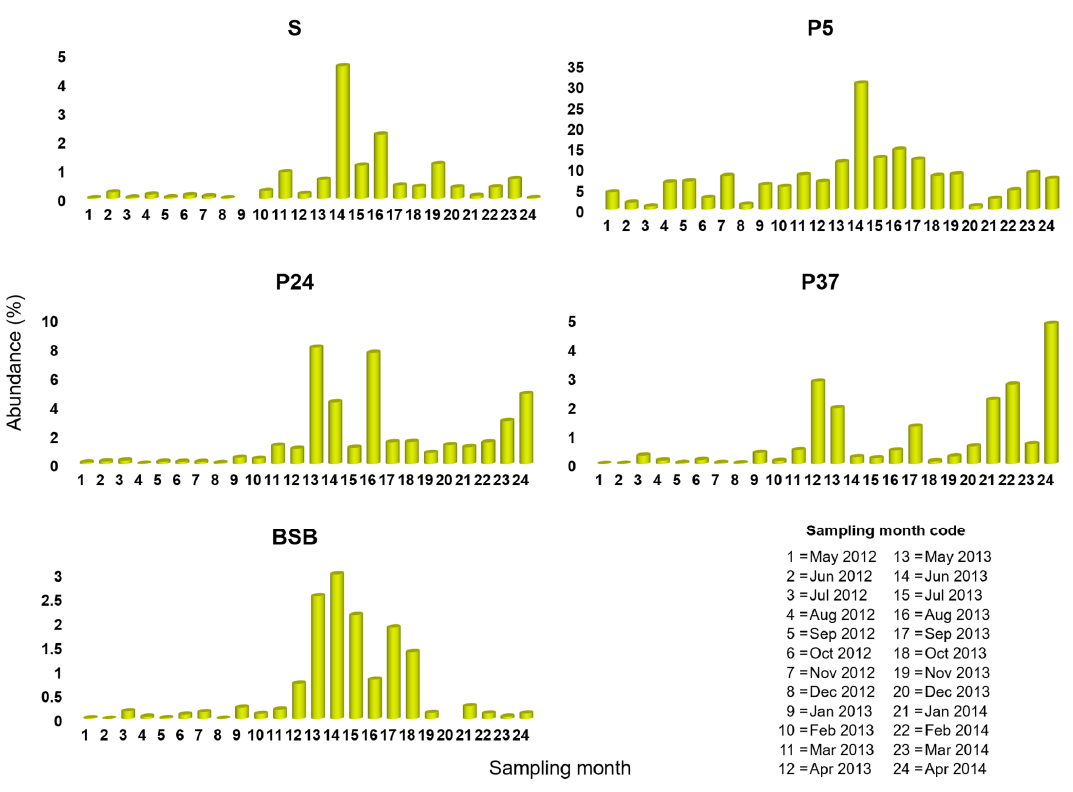
Figure 5. Occurrence of OTU 3194 among the ST sampling sites in the period May 2012–April 2014.